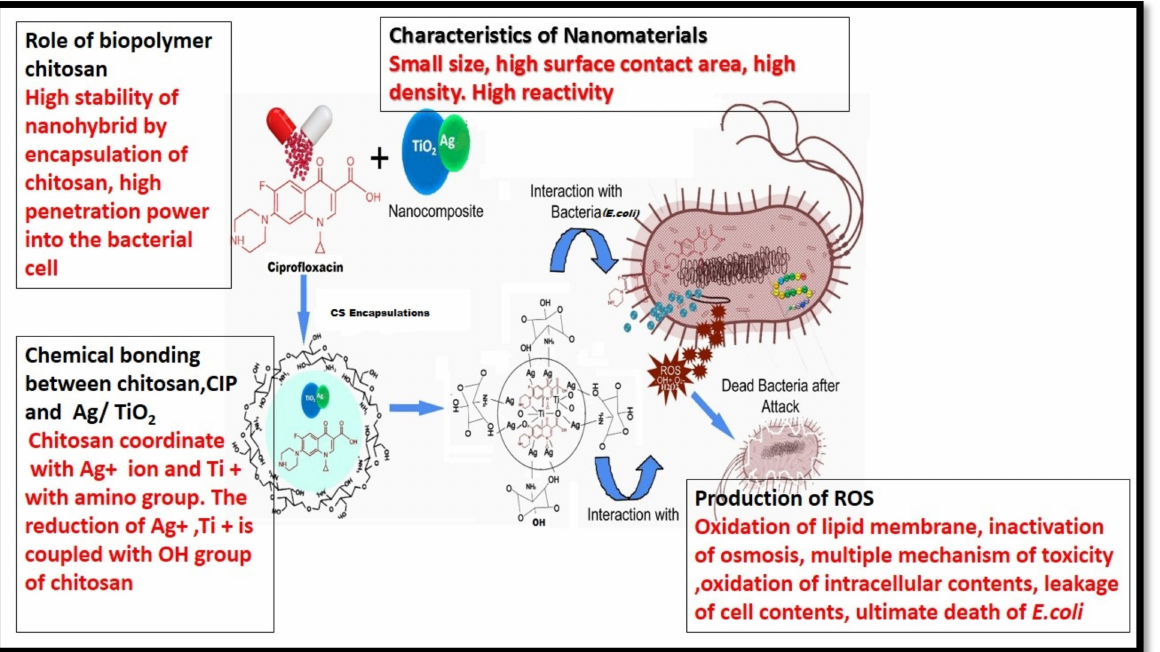
Figure 12. Putative CIP-TiO 2 /Ag/CS nanohybrid-mediated cellular and molecular bactericidal